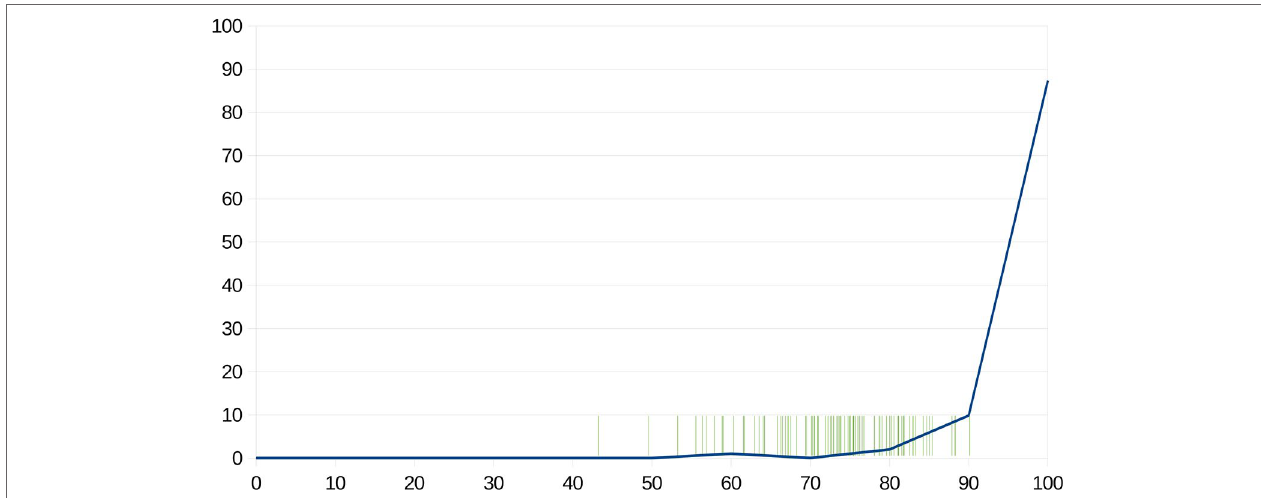
FIgURe 2 | The blue line shows what percentage of the CG achieved a certain percentage of summary response rate. The green lines on the horizontal axis indicate the summary social cognitive response rate of every patient in the study. X-axis: Response rates (in %); Y-axis: ratios of those who achieved the given response rates (in